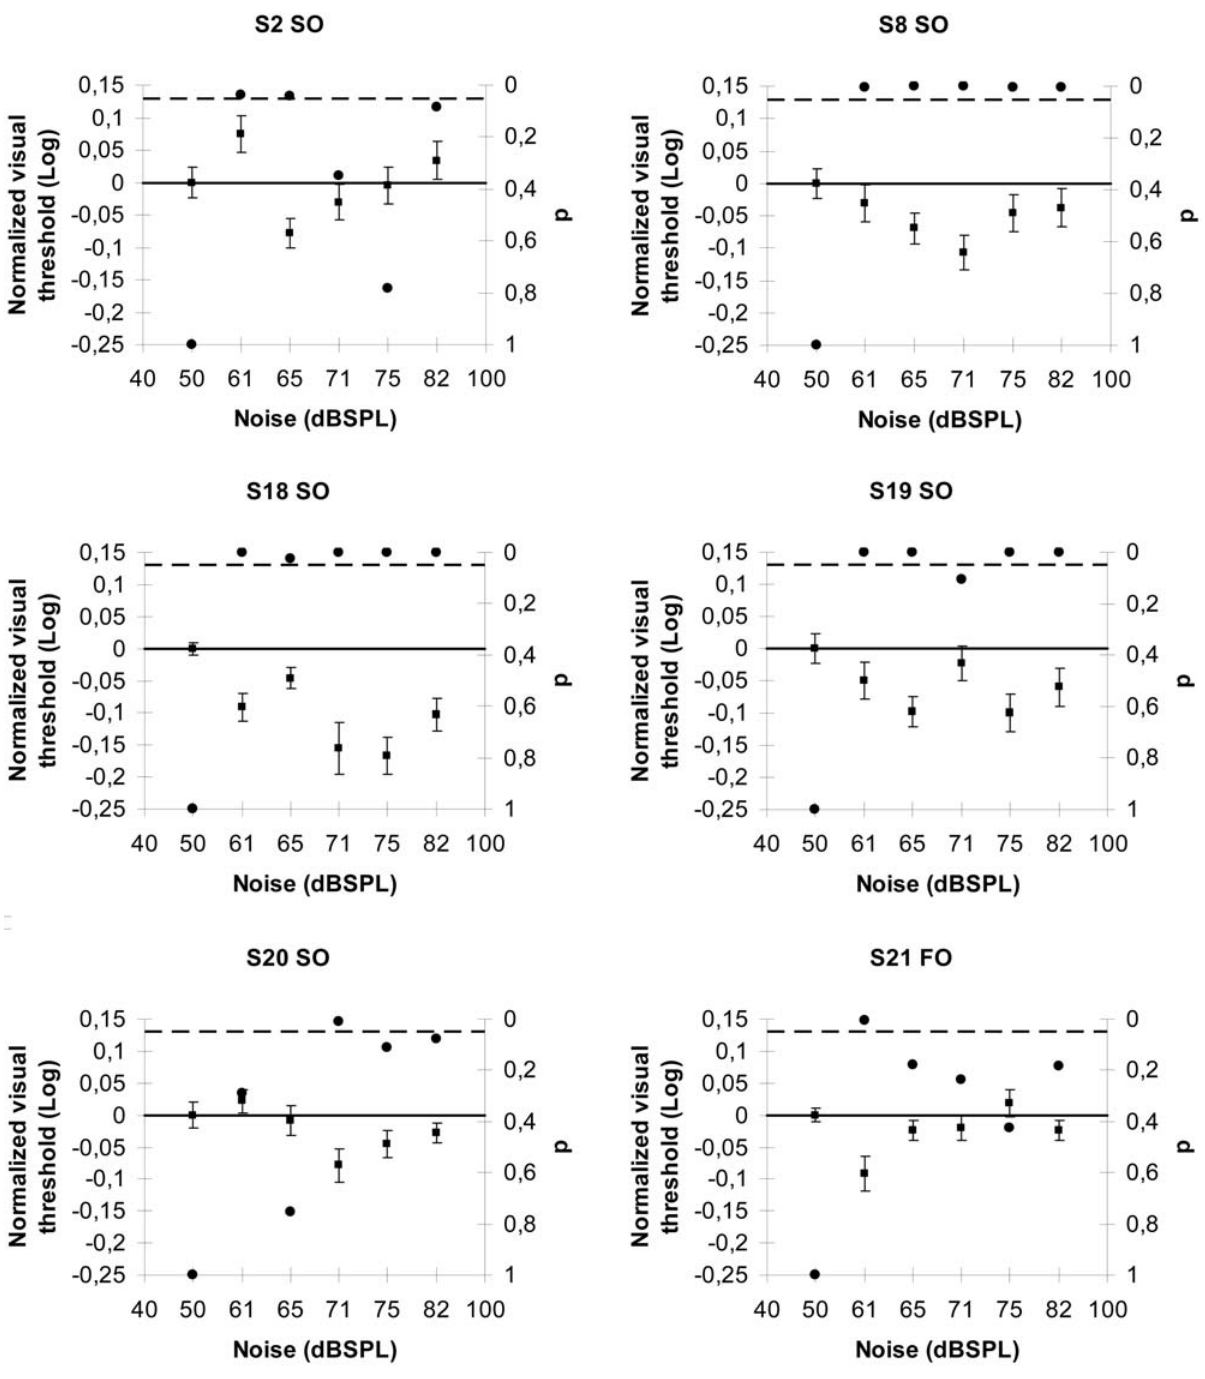
Figure 3. SR interactions between auditory noise and second order visual signals. Normalized visual threshold changes with the noise level in sixth subjects for contrast modulated (second order) stimuli. In all the graphs the no-noise condition is taken as baseline; the black dots indicate p-values (right y-axis) and the broken line represents the 5% significance level. Error bars correspond to one standard error.